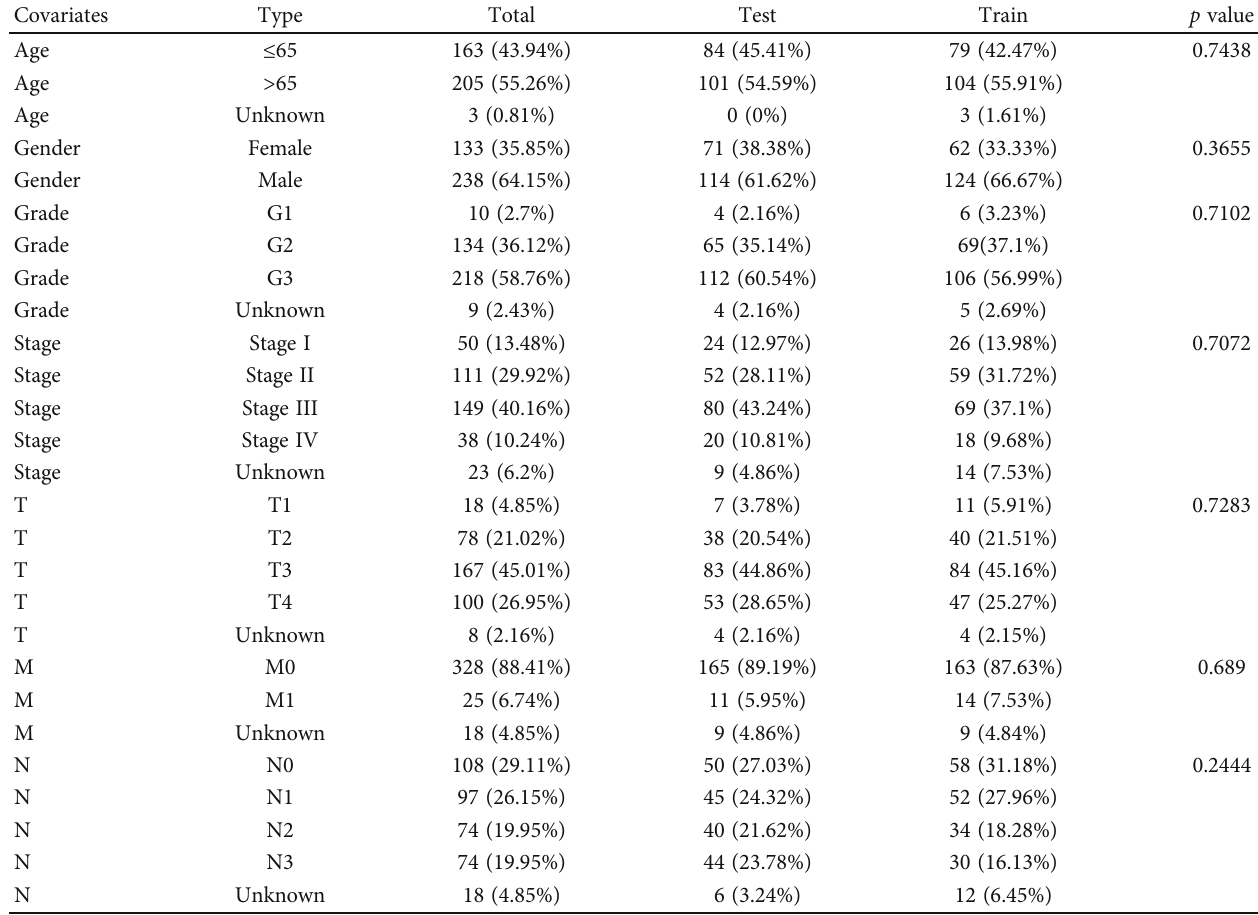
Table 1: General clinical data of the two groups of